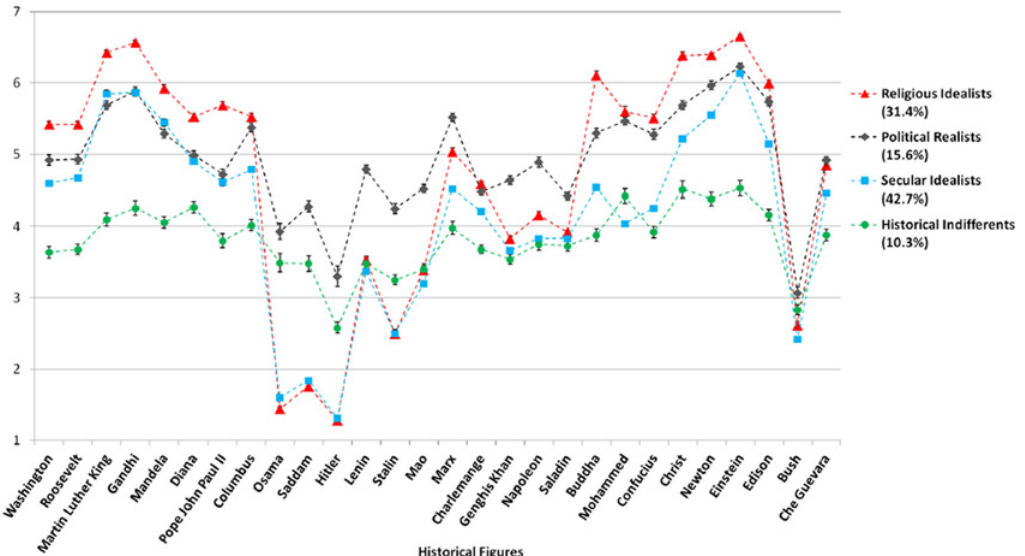
Fig 6. Estimated means for a four-profile Latent Profile Analysis evaluation of historical figures, ordered from left to right according to positions in factor structures (American Presidents, Humanitarians, Explorers, Tyrants, Communists, Conquerors, Religious, Scientists, and